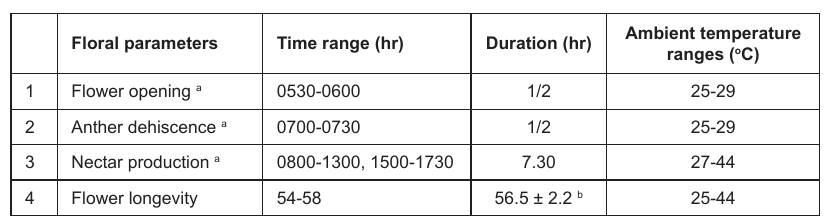
Table 2. Different floral parameters of Sarpagandha in relation to ambient